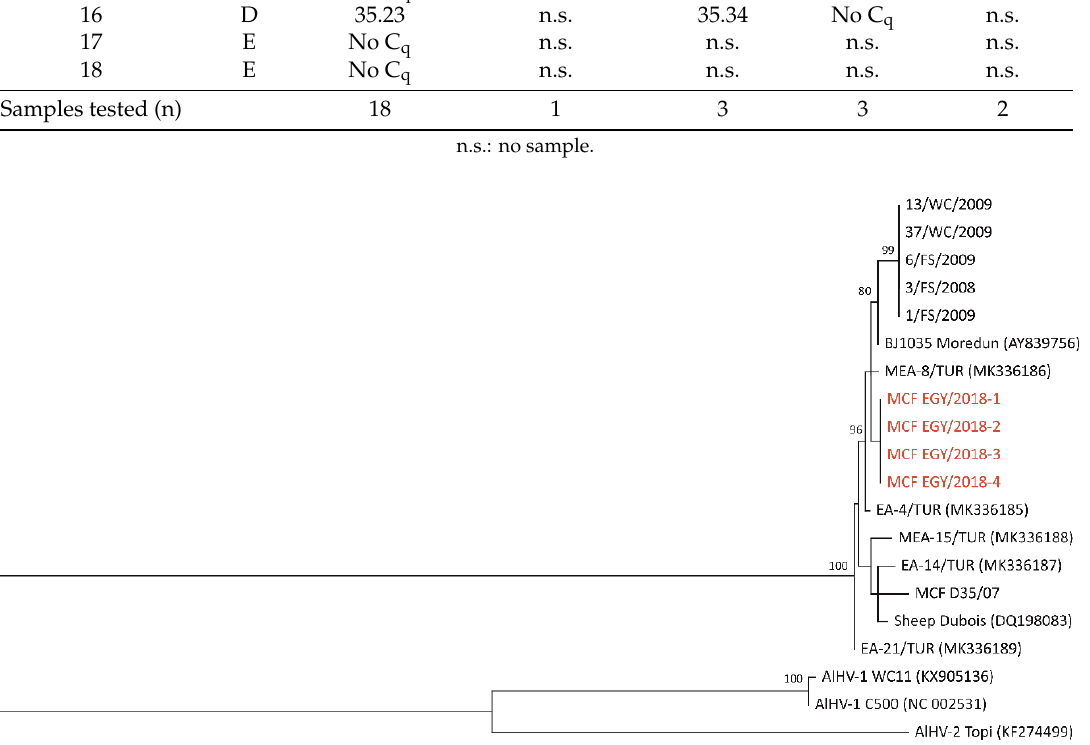
Figure 2. Basic ORF27 phylogeny. Egyptian sequences from this study are highlighted in red. The South African FS (Free State) and WC (Western Cape) sequences are from Doboro et al. [14], Turkish MEA and EA sequences are from Turan et al. [29]. Both datasets are based on laboratory-confirmed cases of MCF. BJ1035 is the first complete ovine gammaherpesvirus 2 (OvHV-2) genome published by Hart et al. [24], which was ultimately derived from a Scottish cow with sheep-associated MCF [12], and DQ198083 is a composite sequence of viral DNA enriched from nasal secretions of 13 sheep at the U.S. Sheep Experiment Station in Dubois, ID, USA, previously published by Taus et al. [30]. The D35/07 sequence is from a case of bovine sheep-associated MCF in Italy in 2007.